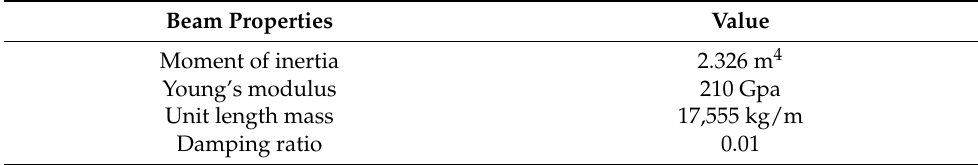
( b ) Figure 8. ( a ) Single-damage of the 69th element under Chi-Chi earthquake; ( b ) multi-damage of the 59th and 64th elements under Chi-Chi earthquake. 5. Conclusions The existing methods for structural damage identification using the TF and MSD are only applied for damage warning. In this paper, an improved method based on MSD of strain TF under unknown seismic excitation is proposed to identify the location of